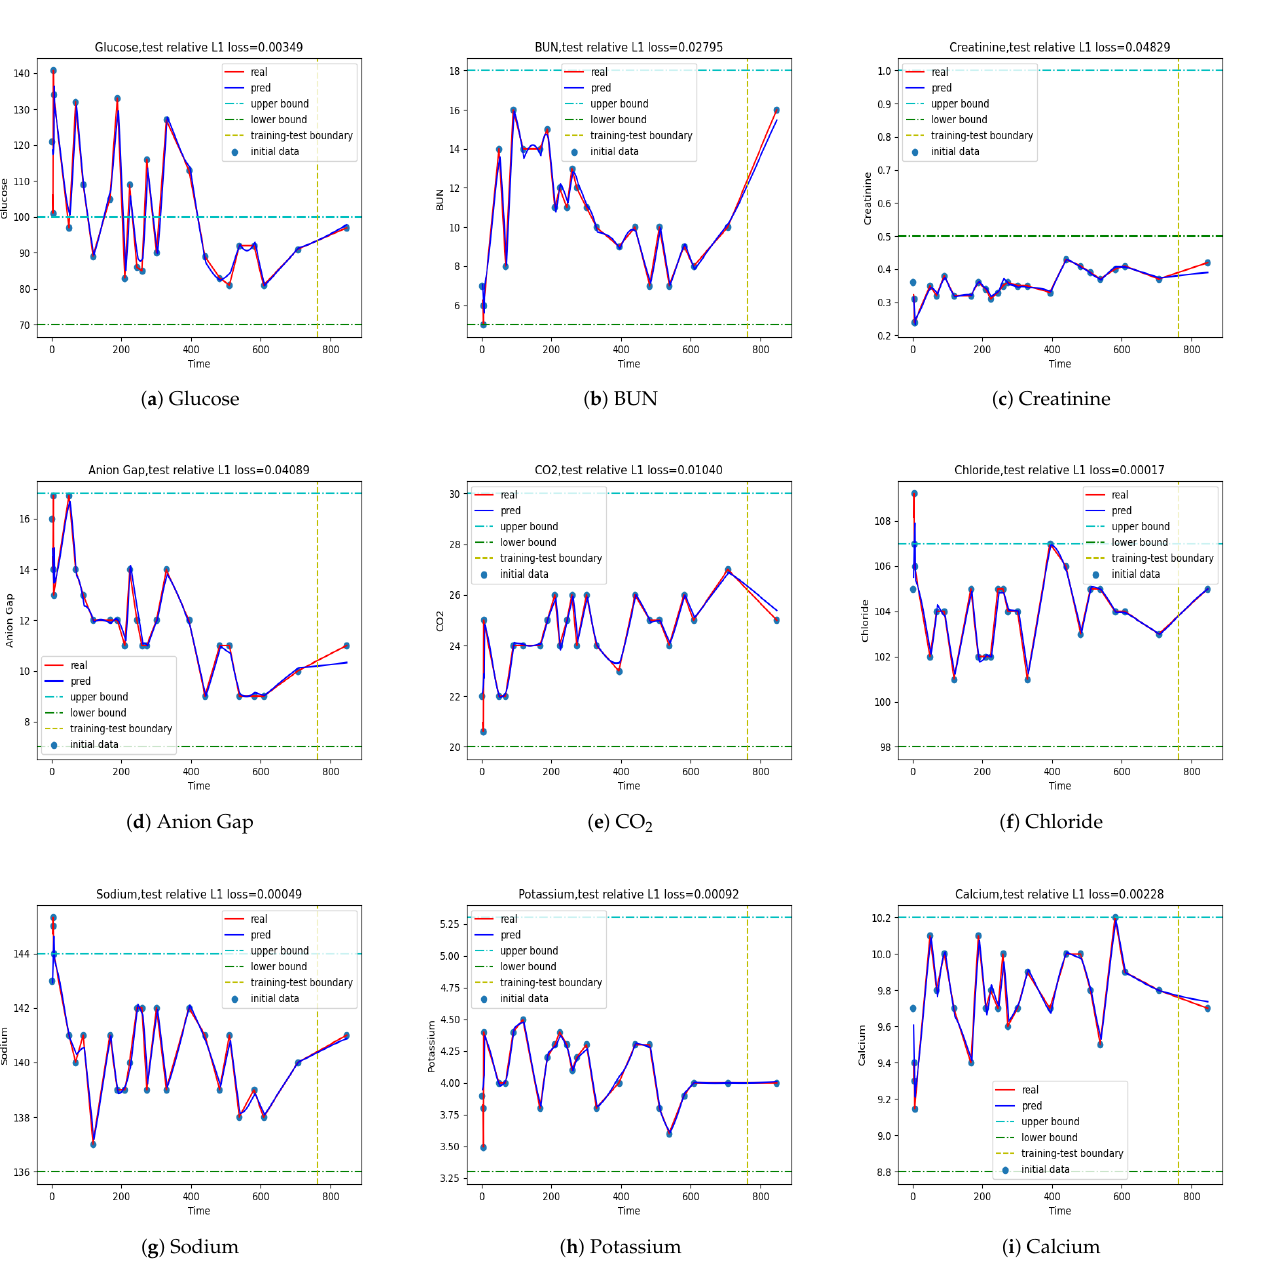
Figure A5. The multistep prediction of the model for patient SCC with T = 1, L =